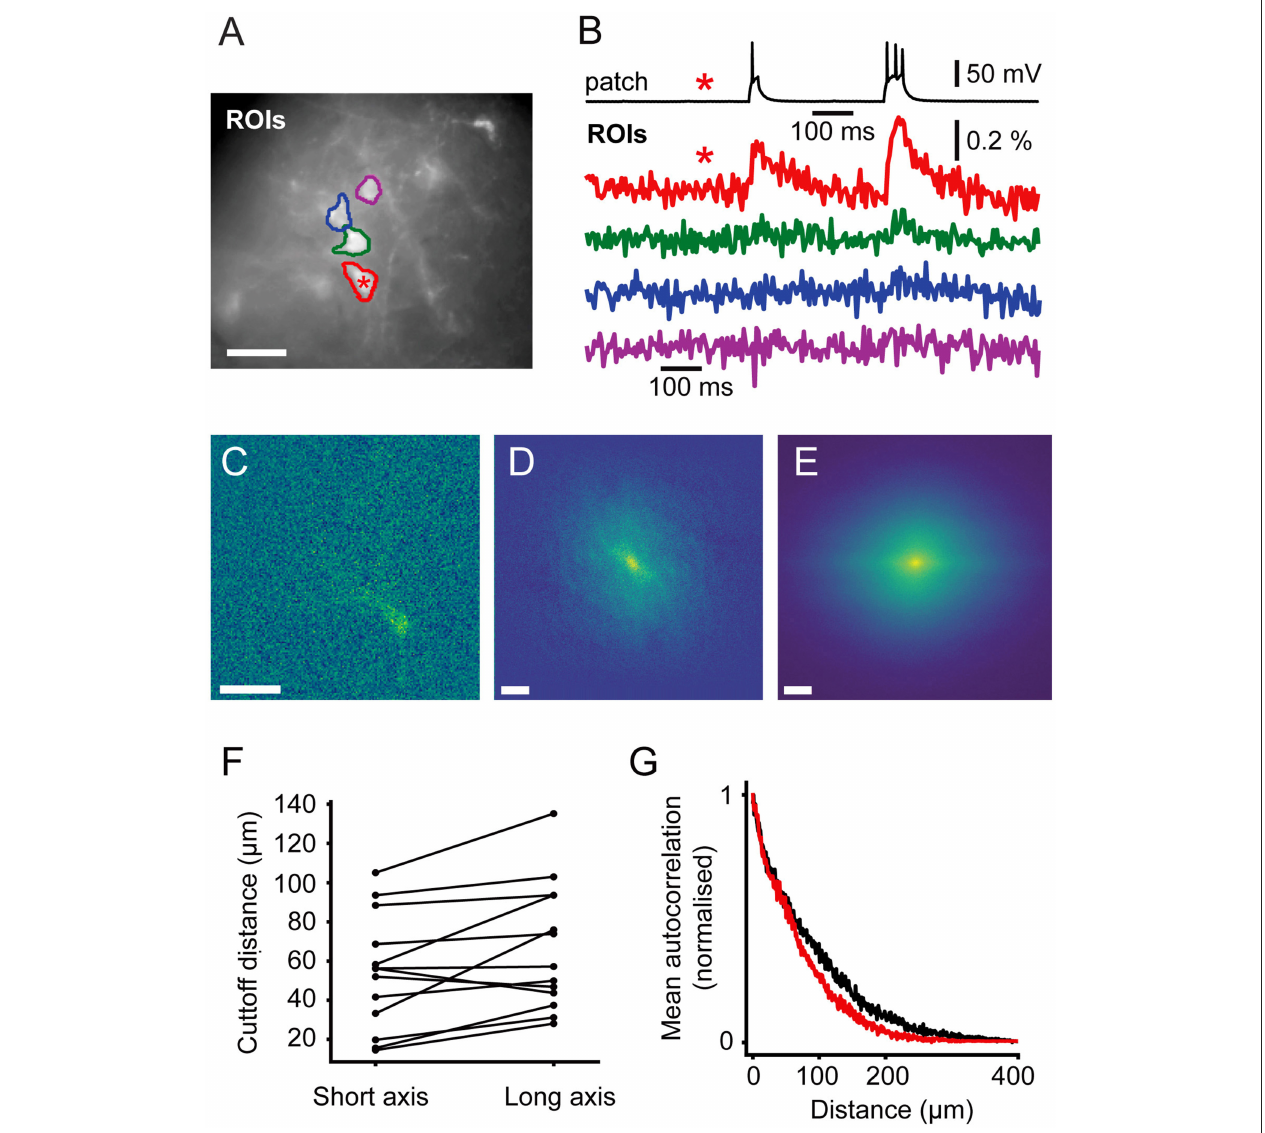
FIGURE 6 | Signal Spread. Autocorrelation of activity maps can be used to estimate crosstalk. (A) Wide-field image of a patched neuron (red roi) with other neurons in the FOV. (B) Electrophysiological and fluorescent trace from the patched active cell (red and black) and fluorescent traces from ROIs over adjacent cells (green, blue and magenta). A small amount of crosstalk can be seen in the time courses of the adjacent cells. (C) A spatially unfiltered activity map of the same neuron calculated by measuring the sum over frames during the depolarizing stimulus. (D) The 2D spatial autocorrelation of the activity map. This represents the fraction of signal power arising from the patched neuron at different separations. (E) The mean of rotationally aligned autocorrelations of all measured cells. (F) The length of the long and short 50% cut-offs for all cells. (G) The profile of the mean autocorrelation for the long (black) and short (red) axes. Scale bars 40 µ